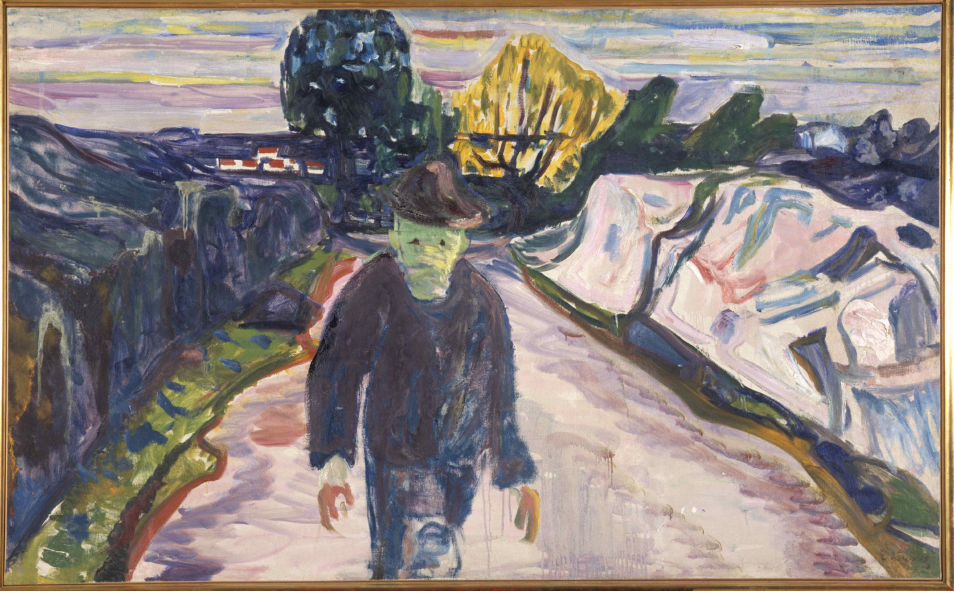
Figure 7: The Murderer (1910) ©